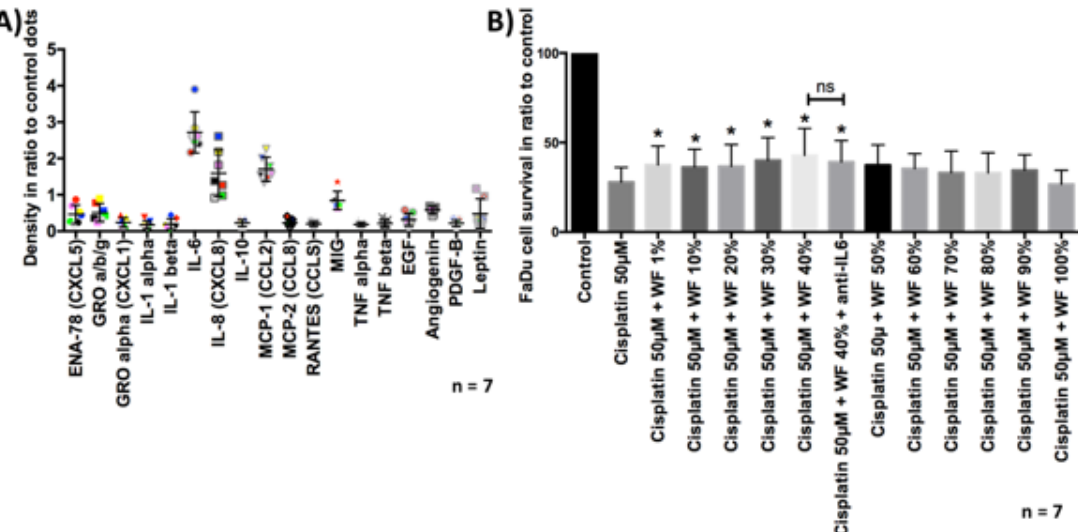
Figure 2. ( A ) Semiquantitative cytokine contents analysis of WF from all seven donors. One dot shows the result of one donor. High levels of IL-6, IL-8, MCR-1, MIG (monokine induced by gamma interferon; CXCL9) are detectable in WF compared with control dots. ( B ) FaDu cell survival was measured by flow cytometry. Previously, cells were treated with cisplatin 50 µM and ±WF at different concentrations. The cultivation with WF at a concentration of 1%, 10%, 20%, 30%, 40%, and 40% + anti-IL6 resulted in a significant improvement of cell survival after cisplatin treatment, compared with cultivation with expansion medium ( n = 7). The addition of anti-IL6 had no statistically significant effect on cell survival. * p < 0.05. n.s. marks the not significant